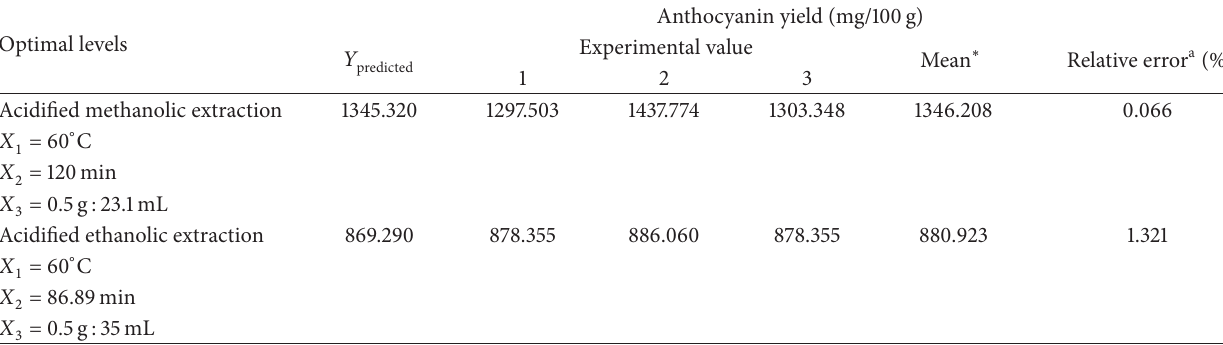
Table 5: Experiment confirmation of predicted value at optimal extraction